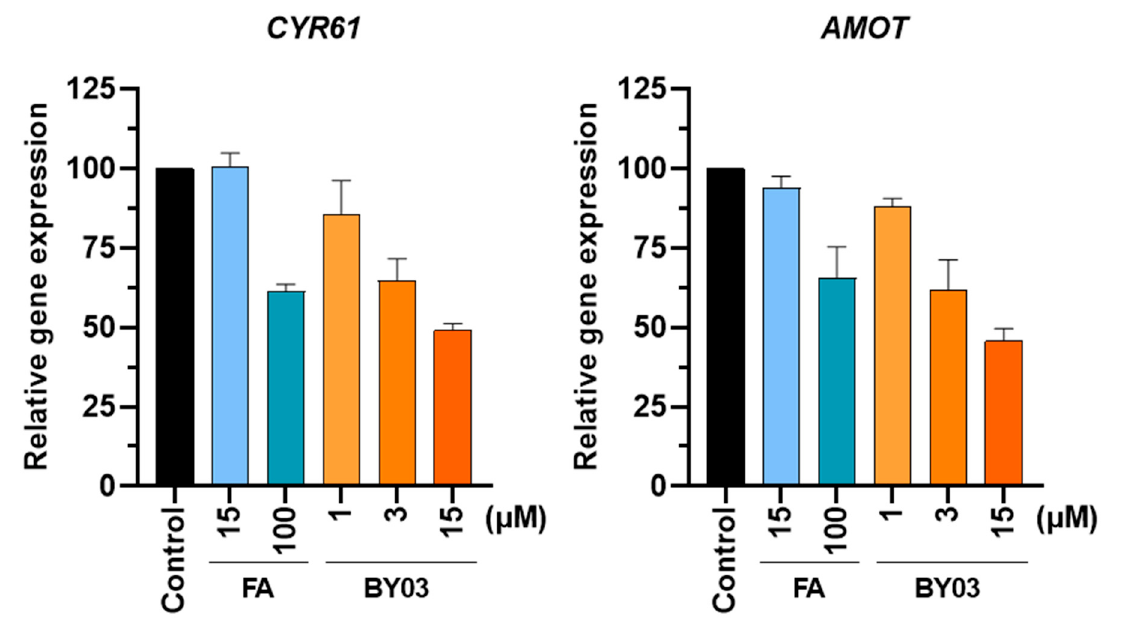
Figure 10. Expression of YAP-TEAD target genes (CYR61 and AMOT) in HEK293T cells incubated in the presence of BY03 at 1 µ M, 3 µ M, 15 µ M, respectively for 24 h. Flufenamic acid (FA) was treated with 15 µ M and 100 µ M, respectively. mRNAs were measured by qRT-PCR ( n = 3).